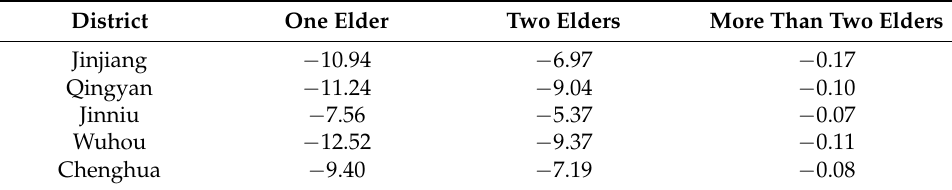
Table 2. Changes in household cohabitation from 2000 to 2010 (Ratio,